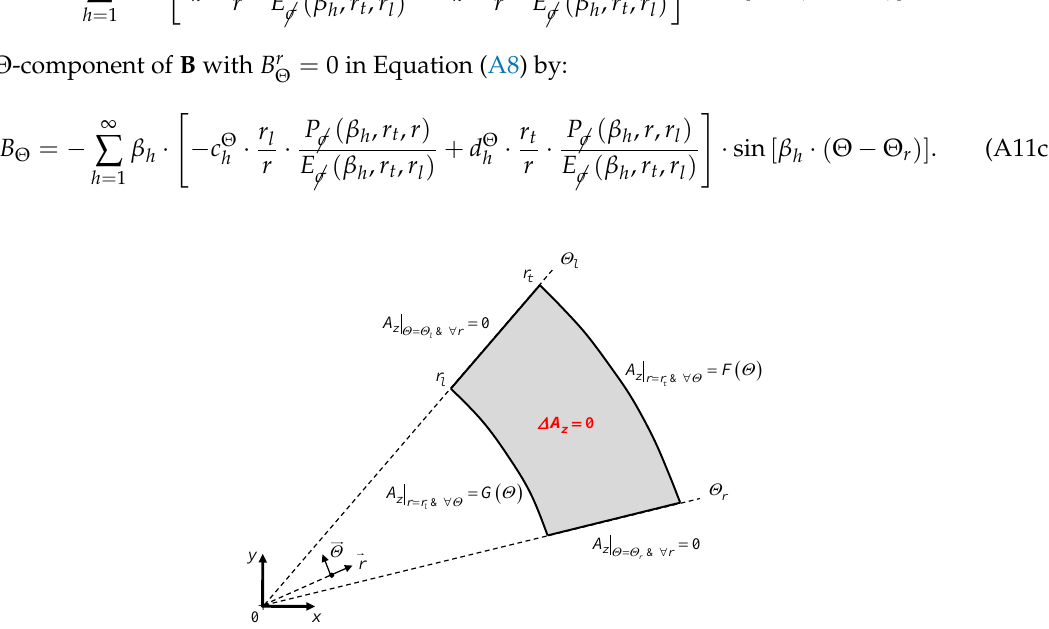
Figure A2. Particular case: A z = 0 on Θ -edges and A z imposed on r -edges of a